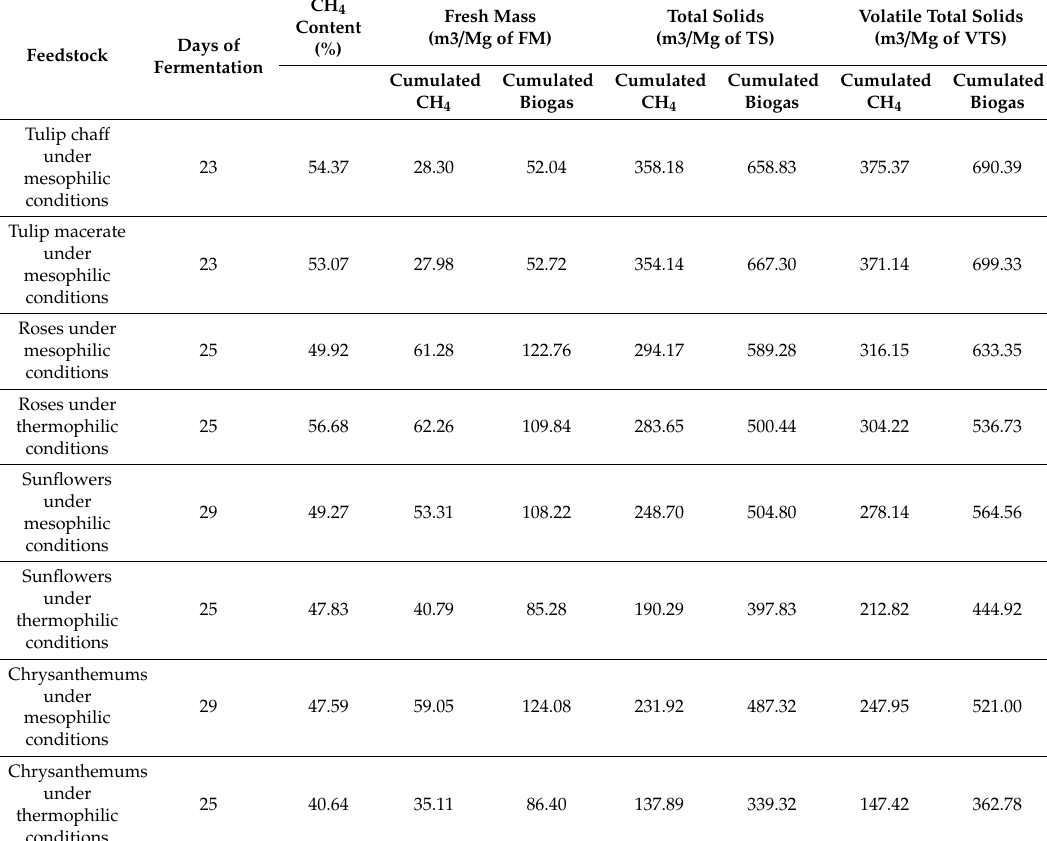
Table 3. Cumulated biogas and methane production from each analyzed